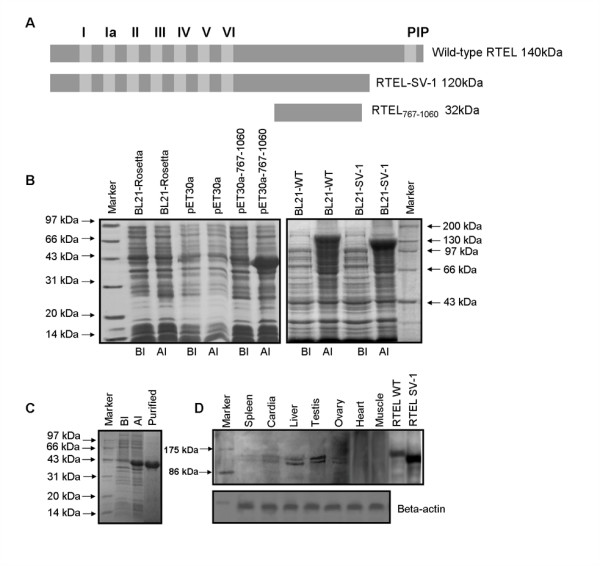
Antiserum preparation and Western blot. Three peptides, the wild-type RTEL protein, the RTEL isoform generated from splice variant 1 and RTEL767-1060 were over-expressed in E. coli. RTEL767-1060 was purified and used to prepare the antiserum for West analysis. (A) Schematic representation of the regions of RTEL that expressed in E. coli. BL21-Rosetta. RTEL-WT represents the complete coding region of RTEL; RTEL SV-1 represents the coding region of splice variants 1; RTEL767-1060 represents a shared coding regionin all potential isoform of RTEL. The roman numbers and 'PIP'specify the conserved helicase motifs and PIP box. (B). Over-expression of wild-type RTEL (WT), RTEL SV-1 (SV-1) and RTEL767-1060 (767–1060) in E. coli BL21-Rosetta induced by IPTG (1 mM). After inducement, the his-tagged recombinant proteins were over expressed. BI and AI listed below means 'before inducement' and 'after inducement' respectively. The empty pET30a-E. coli and wild-type BL21-Rosetta were used as negative controls. (C). Purification of his-tagged RTEL767-1060. RTEL767-1060 is a region shared by all potential RTEL isoforms and was used for antiserum preparation. The homogeneous of purified RTEL767-1060 is >95%. (D). Western analysis of RTEL expression. The lysates of E. coli cells that expressed wild-type RTEL and SV-1 RTEL were used as positive controls. Two bands were detected in the RTEL-expressing tissues, after comparing to the molecular marker and sizes of positive controls, the 140 kDa and the 120 kDa bands are corresponding to the wild-type RTEL and the SV-1 isoform of RTEL respectively.